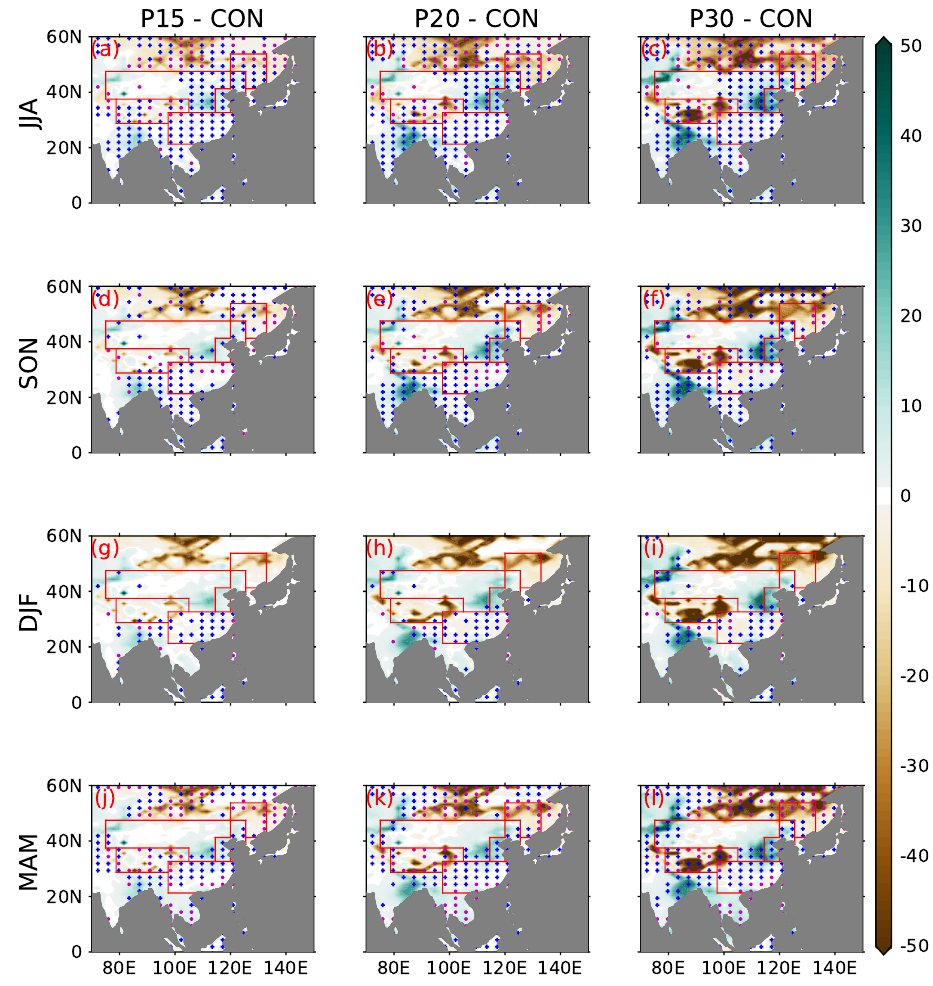
Figure 7. Same as Figure 5, but differences in seasonal-mean soil moisture (kg m − 2 ; shaded) averaged over the depth of the soil column (3 m deep), and surface runoff (mm day − 1 ; stippled; regions of positive change in blue crosses and negative change in magenta circles) for ( a – c ) JJA, ( d – f ) SON, ( g – i ) DJF, ( j – l ) MAM. The five regions are demarcated by the regional boundaries in red. Oceanic regions are masked in